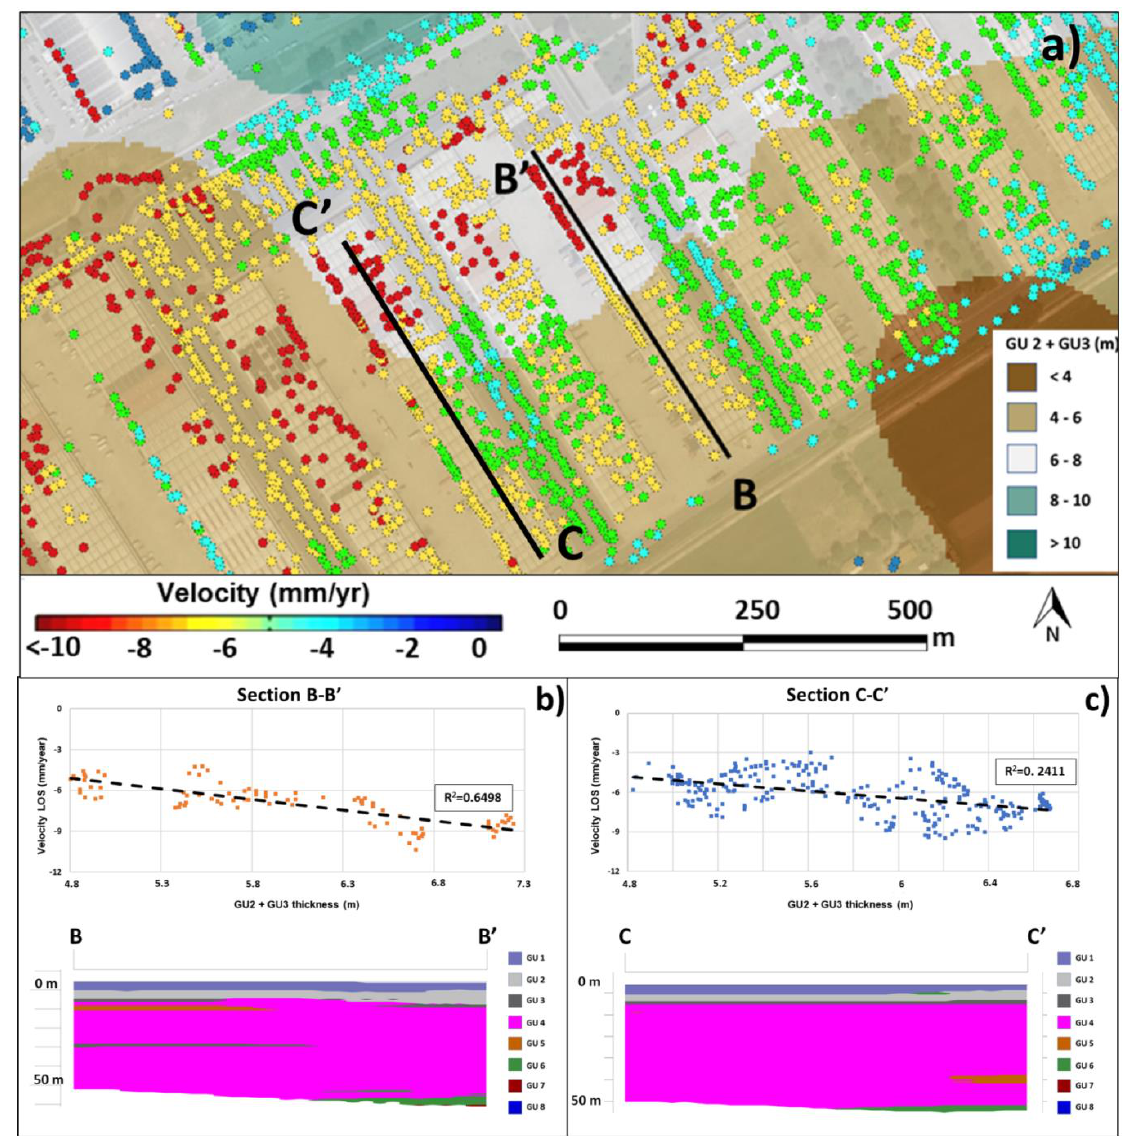
Figure 15. Analysis of the velocity of persistent scatterers on single buildings. ( a ) Classified plot of persistent scatterers over a thickness map of compressible soils. ( b , c ) Correlation diagrams between PS velocity and soft-soil thickness along cross sections (see a for the location) referring to two single buildings.